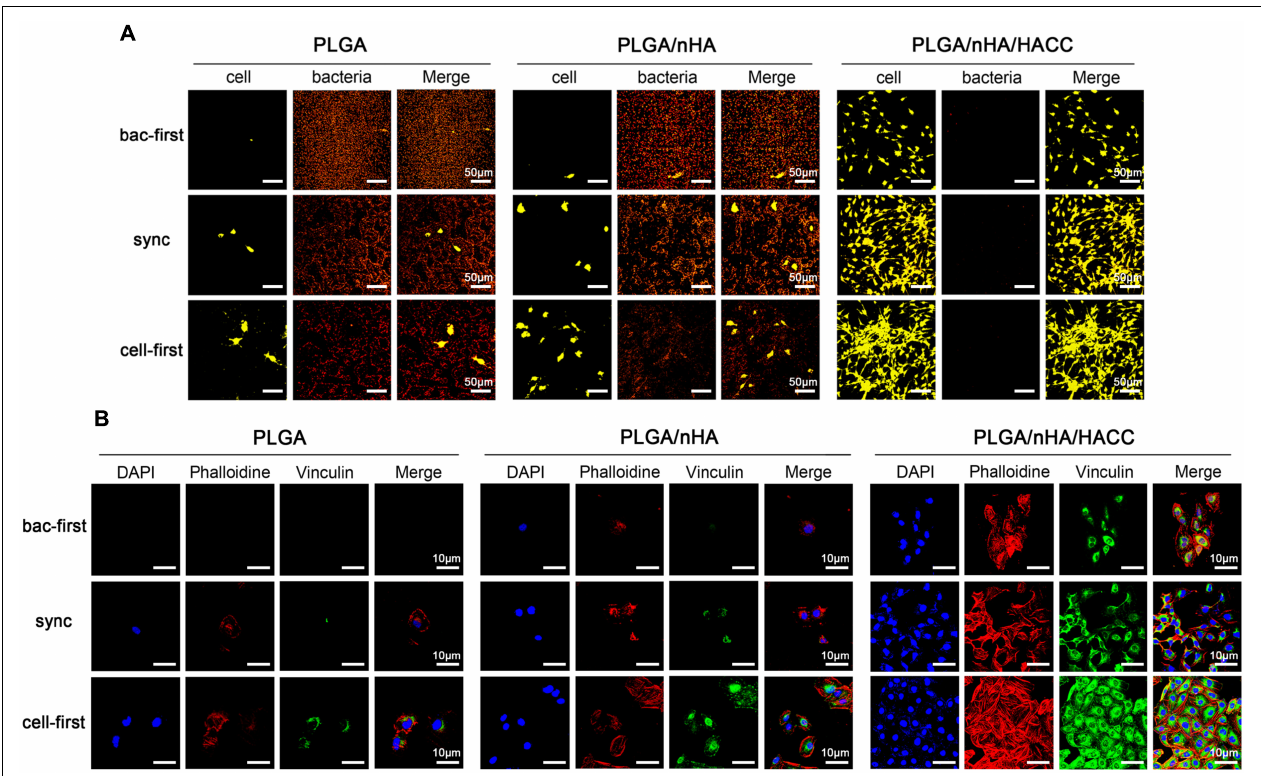
FIGURE 3 | Competitive colonization assay on different materials surfaces in different co-cultured systems. (A) Acridine orange staining of cells and bacteria on the surfaces. Representative images of cells (greenish-orange fluorescence) and bacteria (reddish-orange fluorescence). (B) The cytoskeletal morphology and focal adhesion formation of cells on surfaces. Representative images of cells stained with DAPI for cell nuclei (blue fluorescence), rhodamine phalloidin for actin filaments (red fluorescence), and monoclonal antibody to vinculin for staining the focal adhesions (green